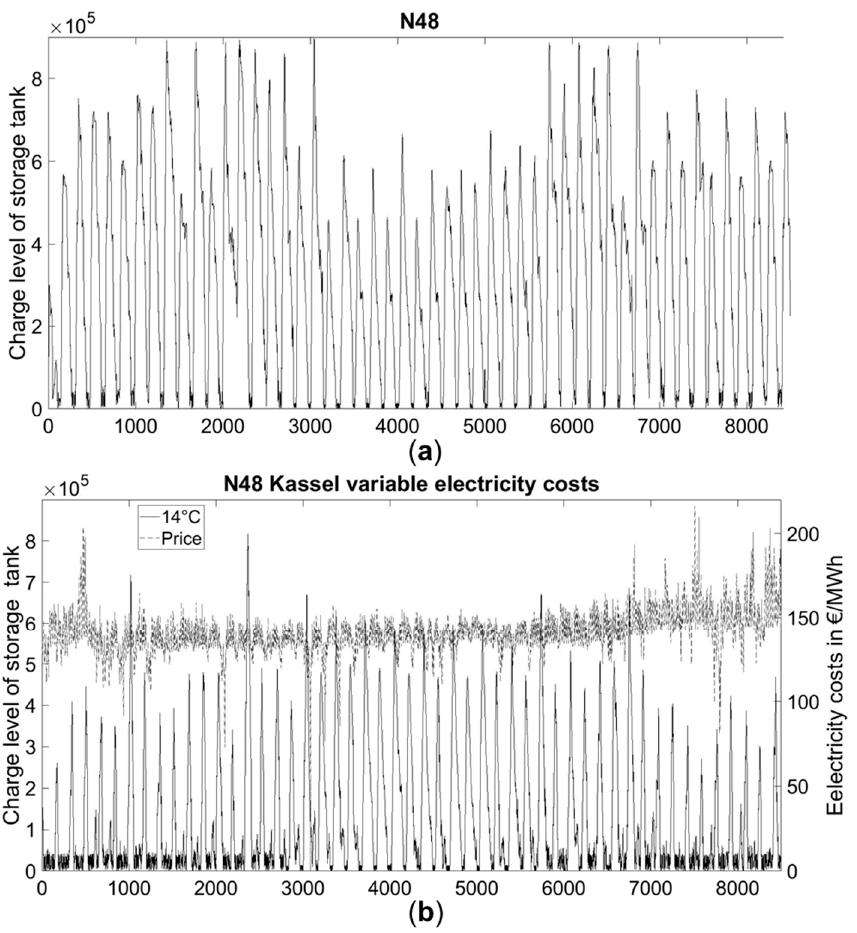
Figure 10. ( a ) Charge level of storage tank for a fixed electricity price; ( b ) charge level of storage tank for variable price scenarios .